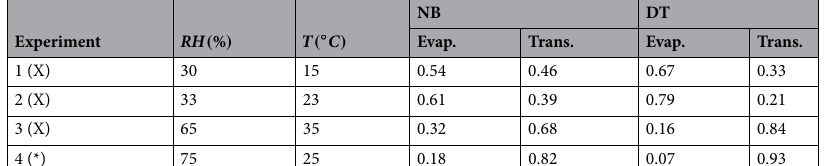
The capability of the model to estimate the regime of droplet is evaluated on an estimation data set from conditions that are unseen by the model and do not contribute to the model training, testing, and validation. The values of RH and T for these conditions are randomly selected in the range of 20% < RH < 80% and 15 < T < 35 ◦ C (shown with cross and star marks on the regime map of Fig. 1b). The model classifies each experi- ment under each regime with different ratios as shown in Table 3. For example, Experiment 1 with RH of 30% ◦ and T of 15 C is close to the boundary of evaporation-dominated and transition regimes. With NB, 54% of the data points in this experiment are classified as evaporation-dominated regime and 46% as transition regime. This is expected due to the location of Experiment 1 on the regime map. It should be noted that the lines on the regime map are approximate boundaries. Figure 2d demonstrates regime estimation of all data points of experiment 4 with both classifiers. The shown evolution of contact angle is not similar to any of the evolutions shown in Fig. 1b subfigures. In fact, contact angle decreases at the beginning and then starts rising. Experiment #4 falls in transition regime. That is the reason that the profile for experimental data in Fig. 2d is colored in red for the true regime of experiment #4. As it is seen, NB and DT correctly classify 84 and 93% of the data points in experiment 4 to transition regime. The green regions represent the data points that are incorrectly classified as evaporation-dominated regime.